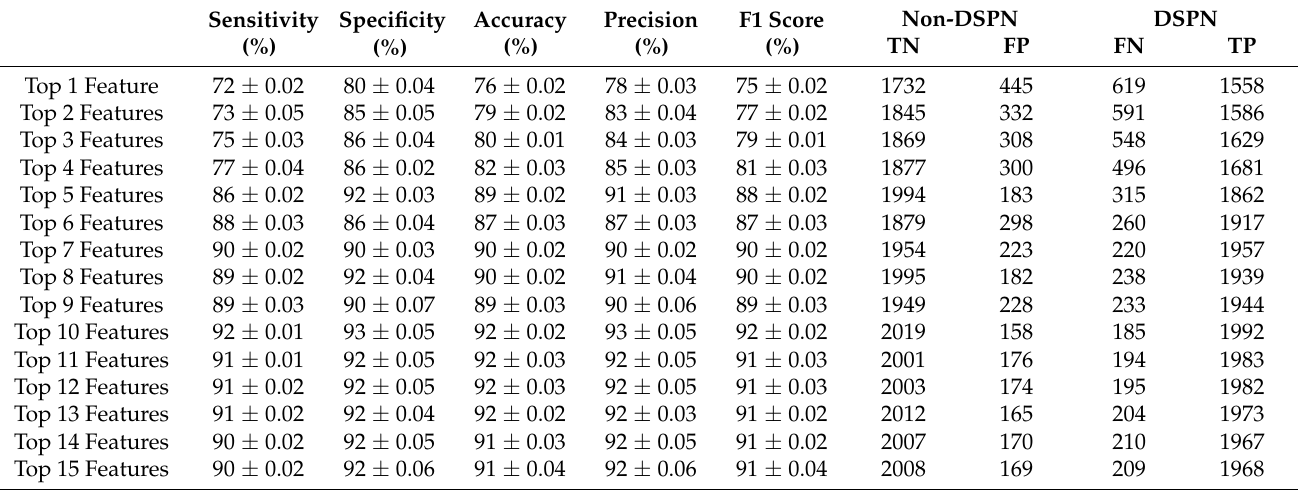
Table 2. Average performance matrix vs. confusion matrix from five-fold cross-validation for top-15- ranked features utilizing the MICE data imputation and logistic regression classification techniques for extra tree feature selection algorithms.